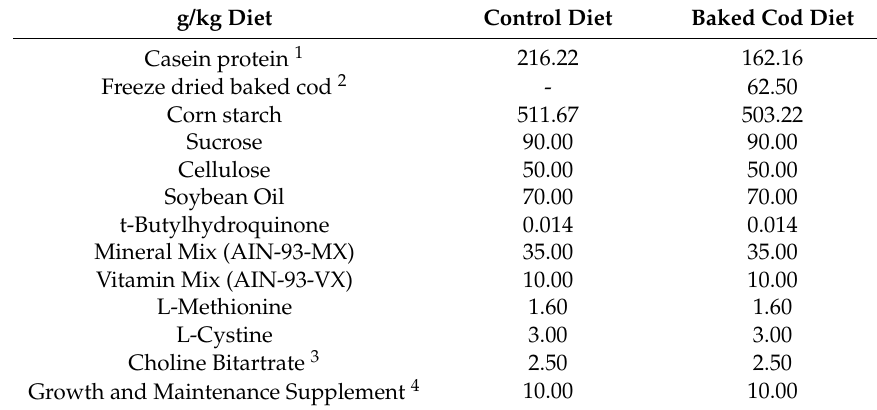
Table 1. Composition of the experimental